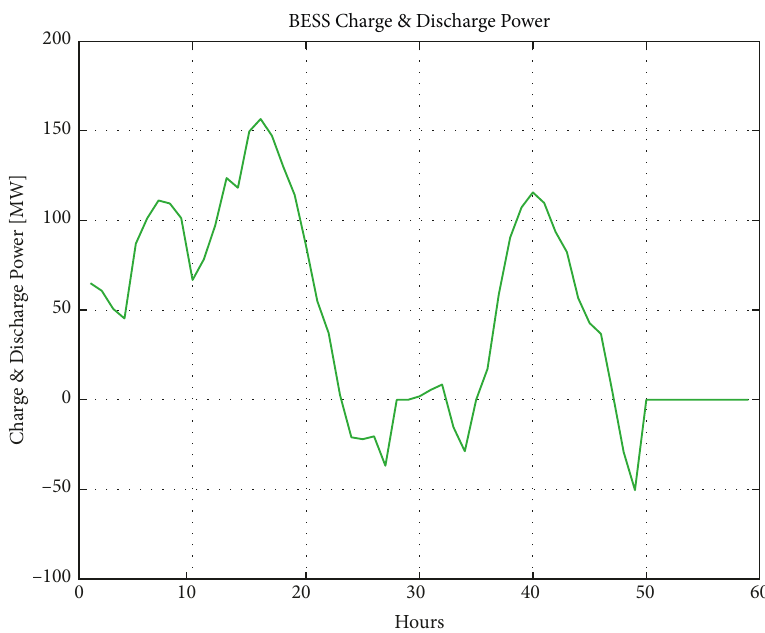
Figure 17: The BESS charge and discharge